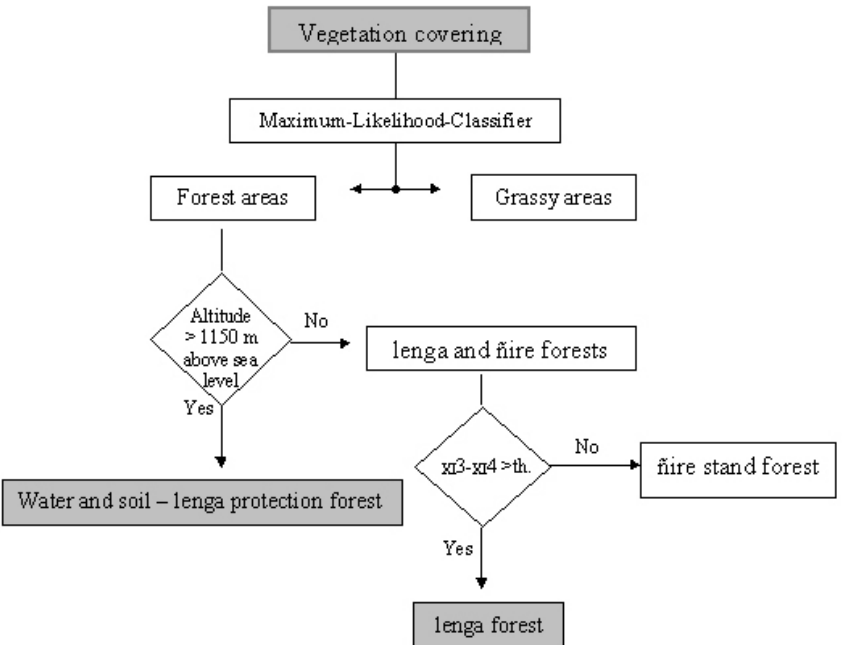
FIGURE 2 . Overview of the classification process. th.: